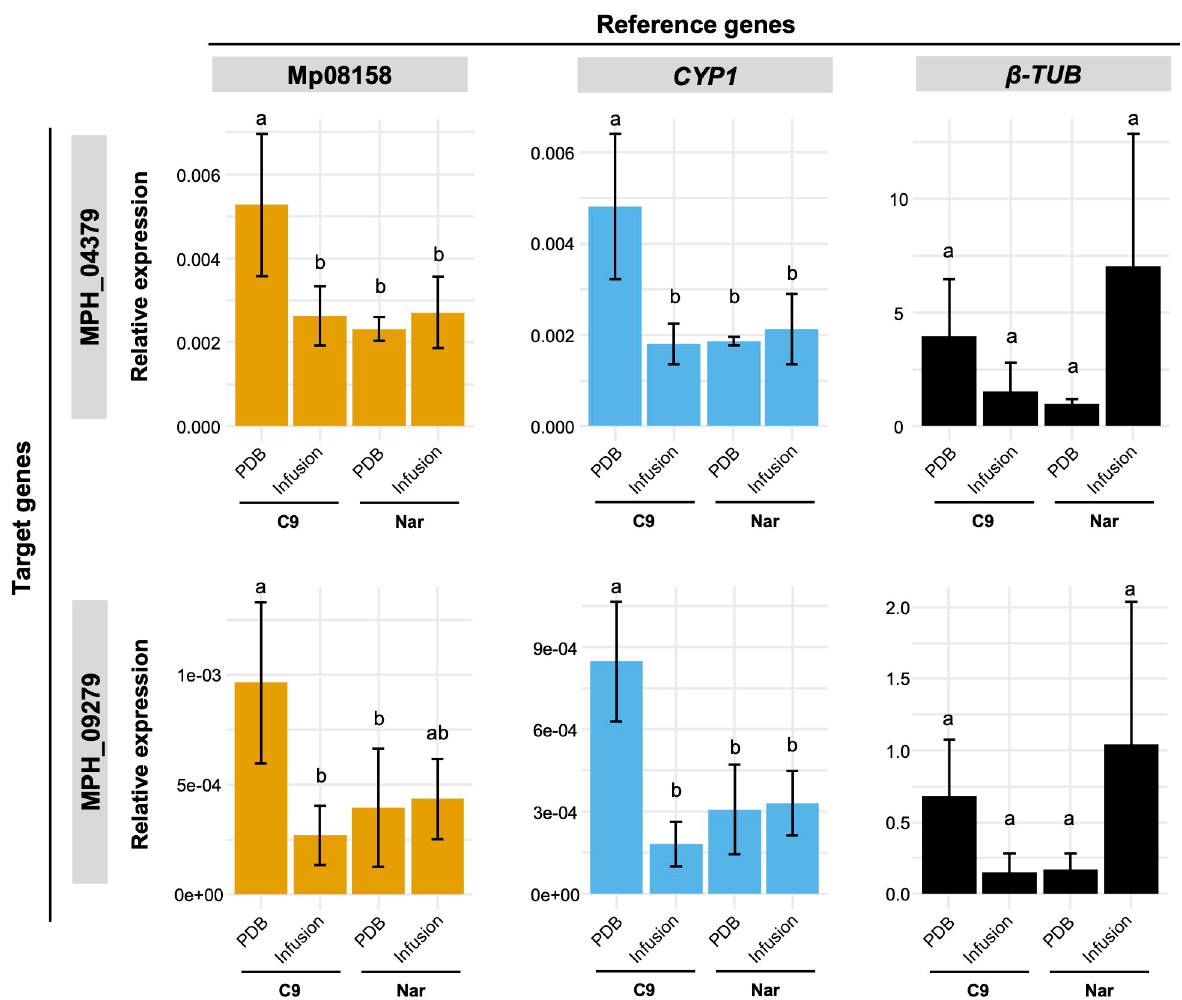
Fig 4. Expression of two cutinase genes of M . phaseolina grown in PDB with soybean leaf infusion. Expression analysis of cutinase genes MPH_04379 (top) and MPH_09279 (bottom) was performed to validate the reference genes. RNA was extracted from M . phaseolina isolates C9 and Nar grown in PDB medium and PDB with soybean leaf infusion. Mp08158 (left) and CYP1 (middle) were used as recommended internal controls, and β -TUB (right) was used as worst internal control. Data are mean ± standard deviation of at least three biological replicates. Different letters above the bars indicate significant differences at P < 0.05 (Tukey’s